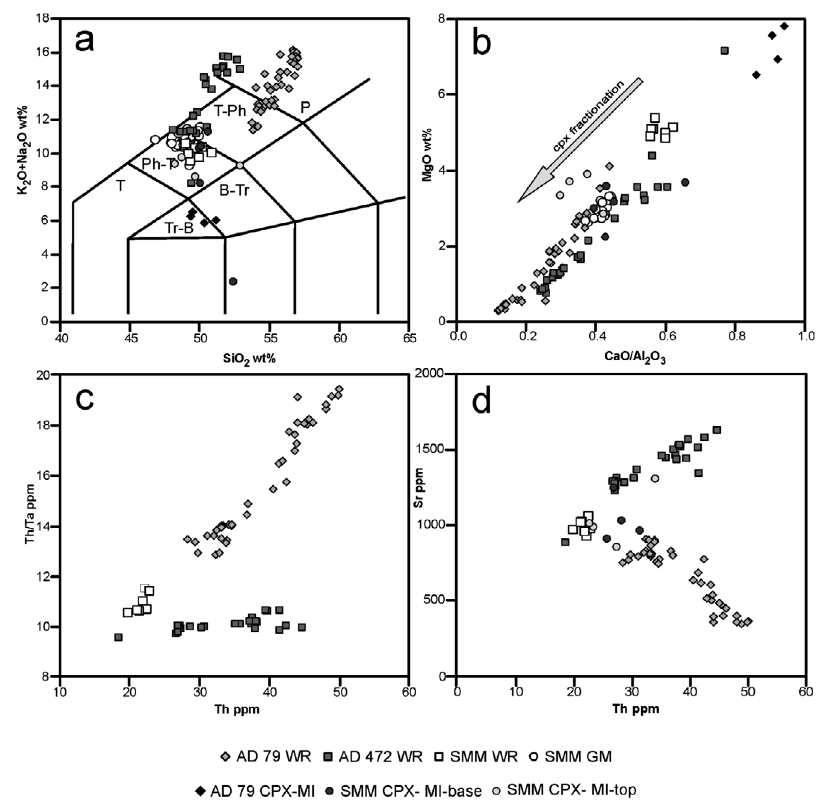
Figure 7. Variation diagrams of major and trace elements in bulk rocks of SMM (white squares), Pompeii (light grey diamonds) and Pollena (grey squares). Matrix glasses and MI of SMM are also reported (white and red circles, respectively) and MI in diospides of Pompei (black di- amonds). A) Total alkali vs silica diagram [Le Bas et al. 1986]; T, tephrite; Ph-T, phonolitic tephrite; T-Ph, tephritic phonolite; P, phonolite; Tr-B, trachibalsalt; B-Tr, basaltic trachite. C-D) Trace elements variation in bulk rock from SMM compared with Pollena and Pompei rocks. WR, whole rock; GM, groundmass; CPX, clinopyroxene; MI, melt